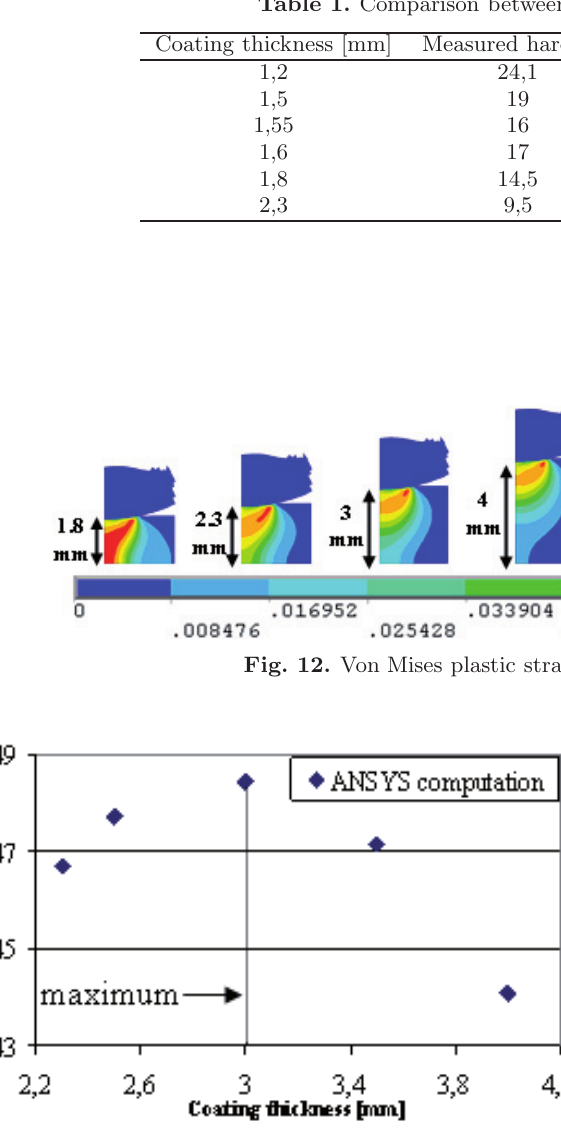
Fig. 13. Reaction force applied to the coating bottom within the range x ∈ [0,2.54] .